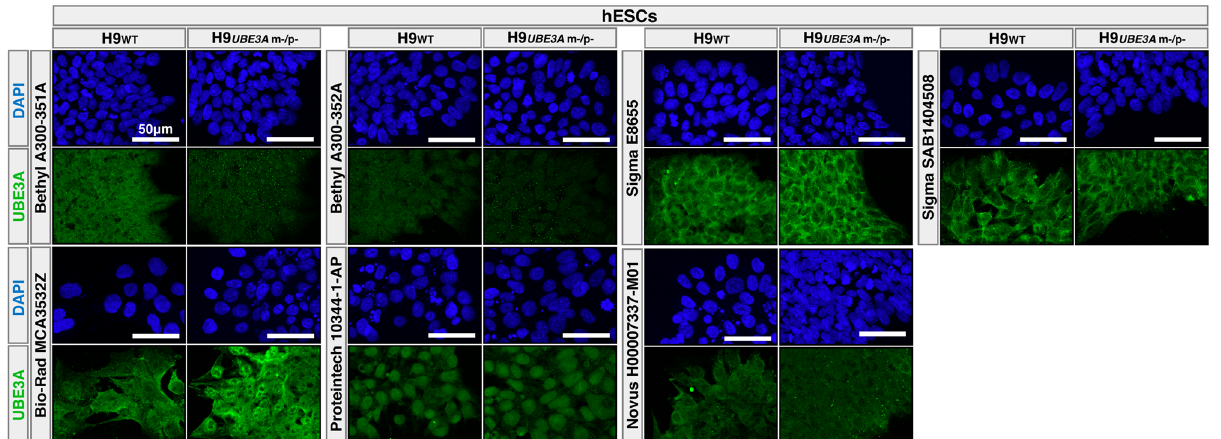
Figure 2. Commercial antibodies vary significantly in background signal in double UBE3A knockout pluripotent cells. Immunofluorescence analysis of H9 wild type (H9 WT ) and H9 double UBE3A knockout (H9 UBE3 m−/p− ) hESCs using seven different UBE3A